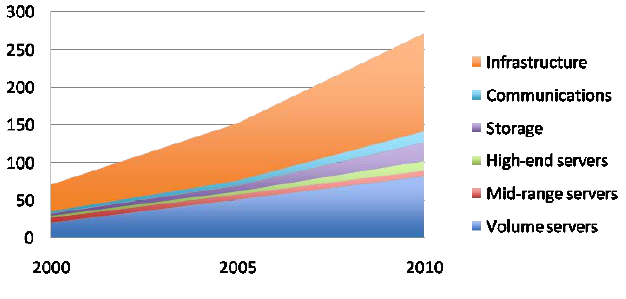
Figure 2. World servers installed (thousands).